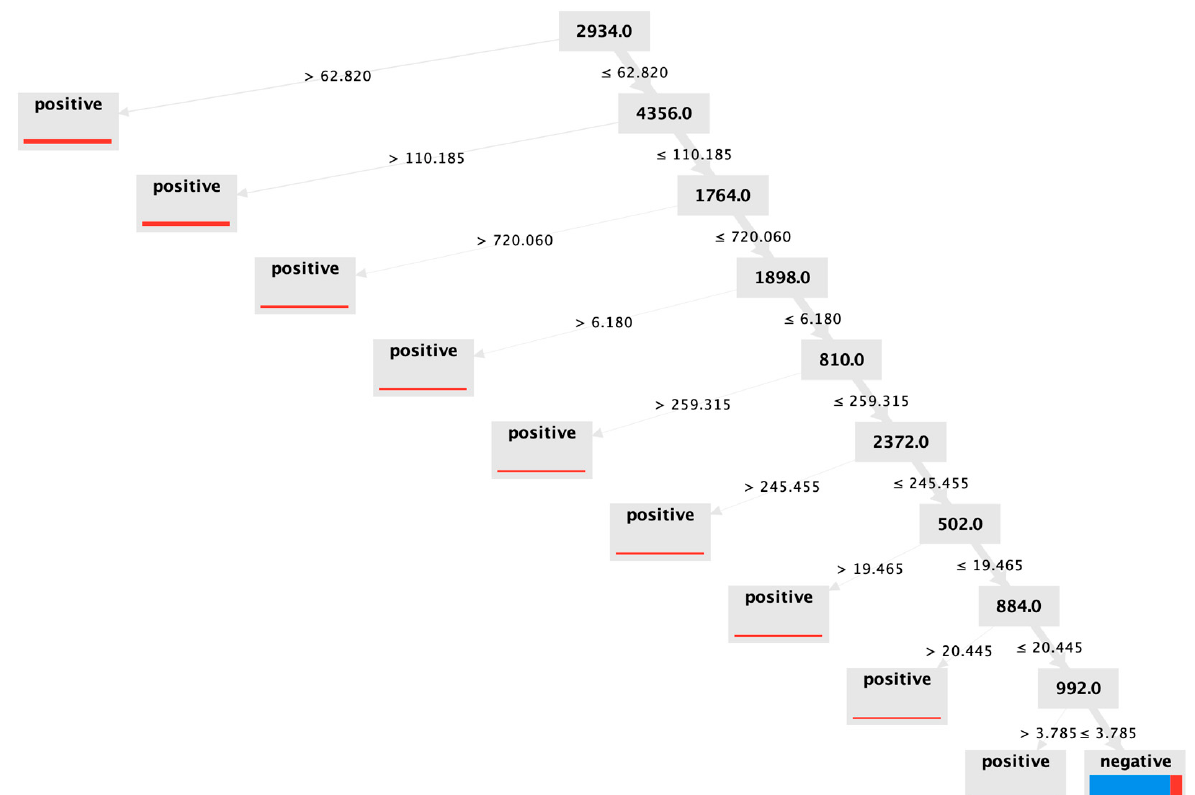
Figure 2. Decision tree model generated by RapidMiner for the learning/training set. The numbers within grey boxes represent m/z values from MALDI spectra—thus they are useful guides to identify potential biomarkers indicative of mastitis. This decision tree represents the model, trained from 226 samples of known SCC. In the bottom right corner, 129/148 samples were correctly sorted as negative. Conversely, 78/97 positive samples were correctly sorted during model building.